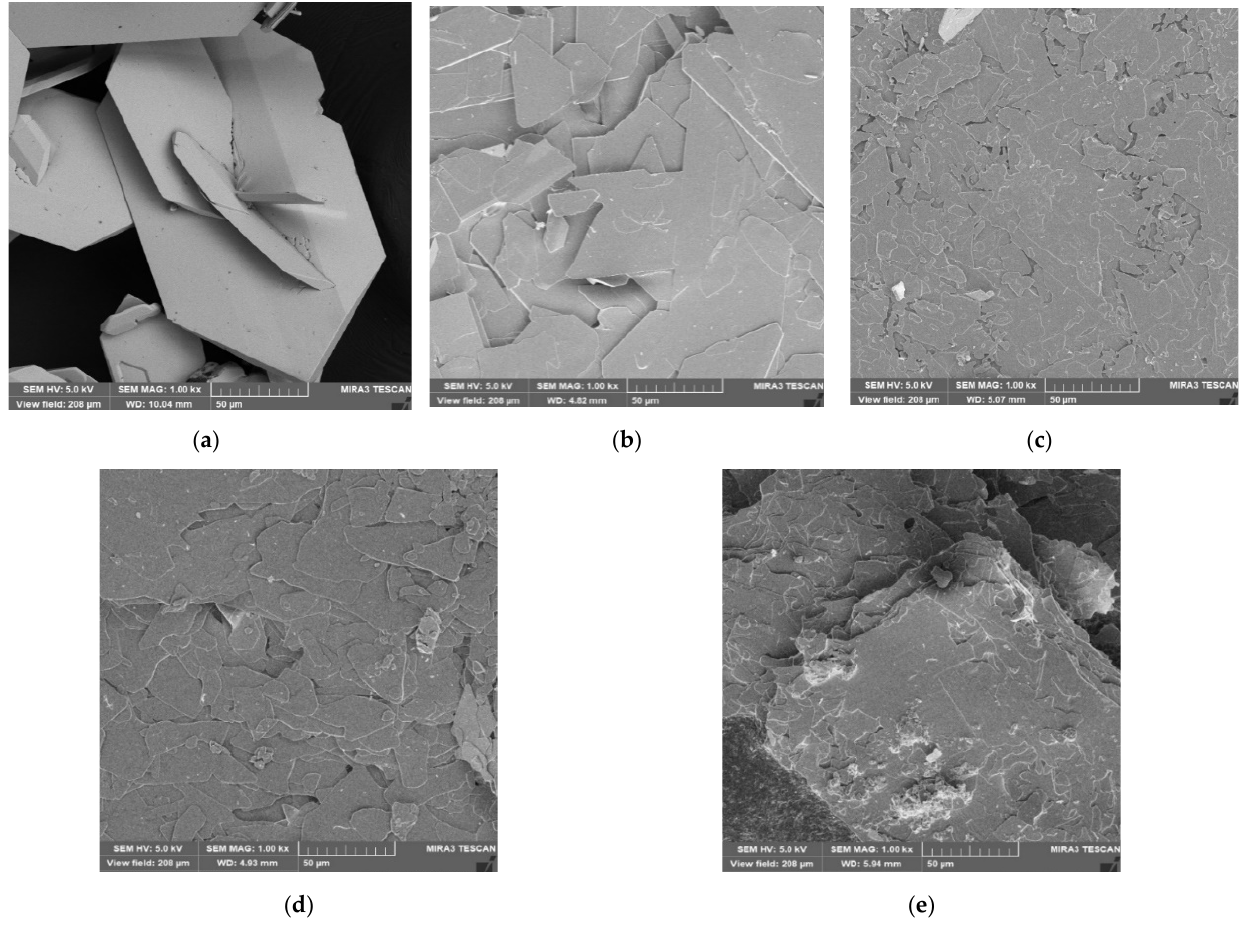
Figure 5. SEM micrographs of Nd 2 (SO 4 ) 3 .8H 2 O product at a magnification of 1000 ×. ( a ) O/A= 0.6; ( b ) O/A = 0.8; ( c ) O/A =1.0; ( d ) O/A =1.2; and ( e ) O/A = 1.4. ( b ) O/A = 0.8; ( c ) O/A =1.0; ( d ) O/A =1.2; and ( e ) O/A =